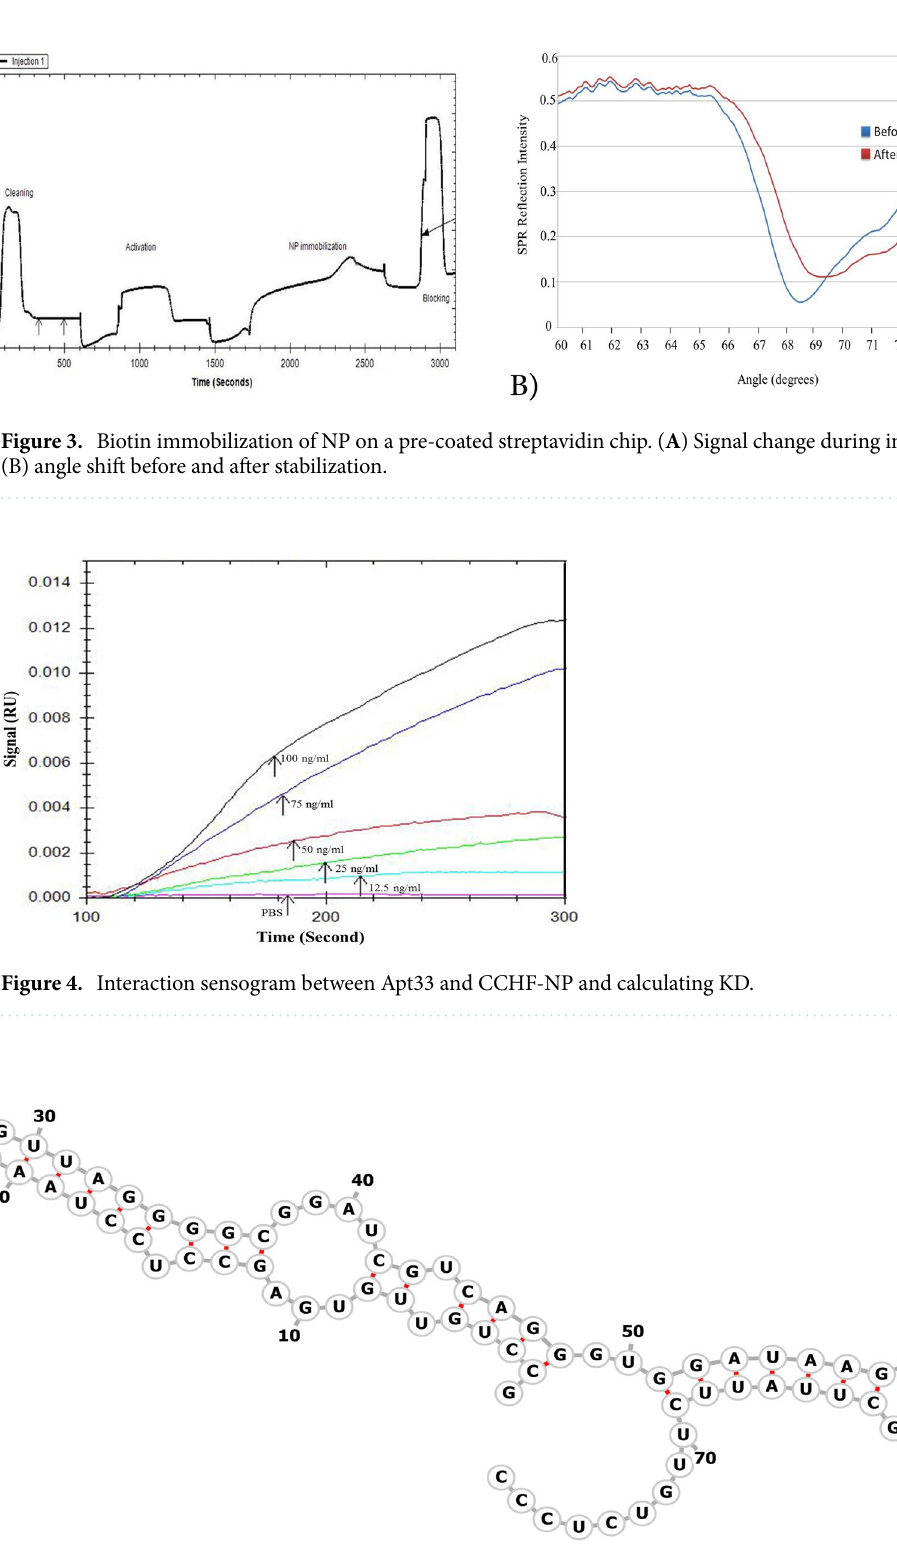
Figure 5. Possible 2D structures of the minimum free energy for apt33 as predicted by ViennaRNA